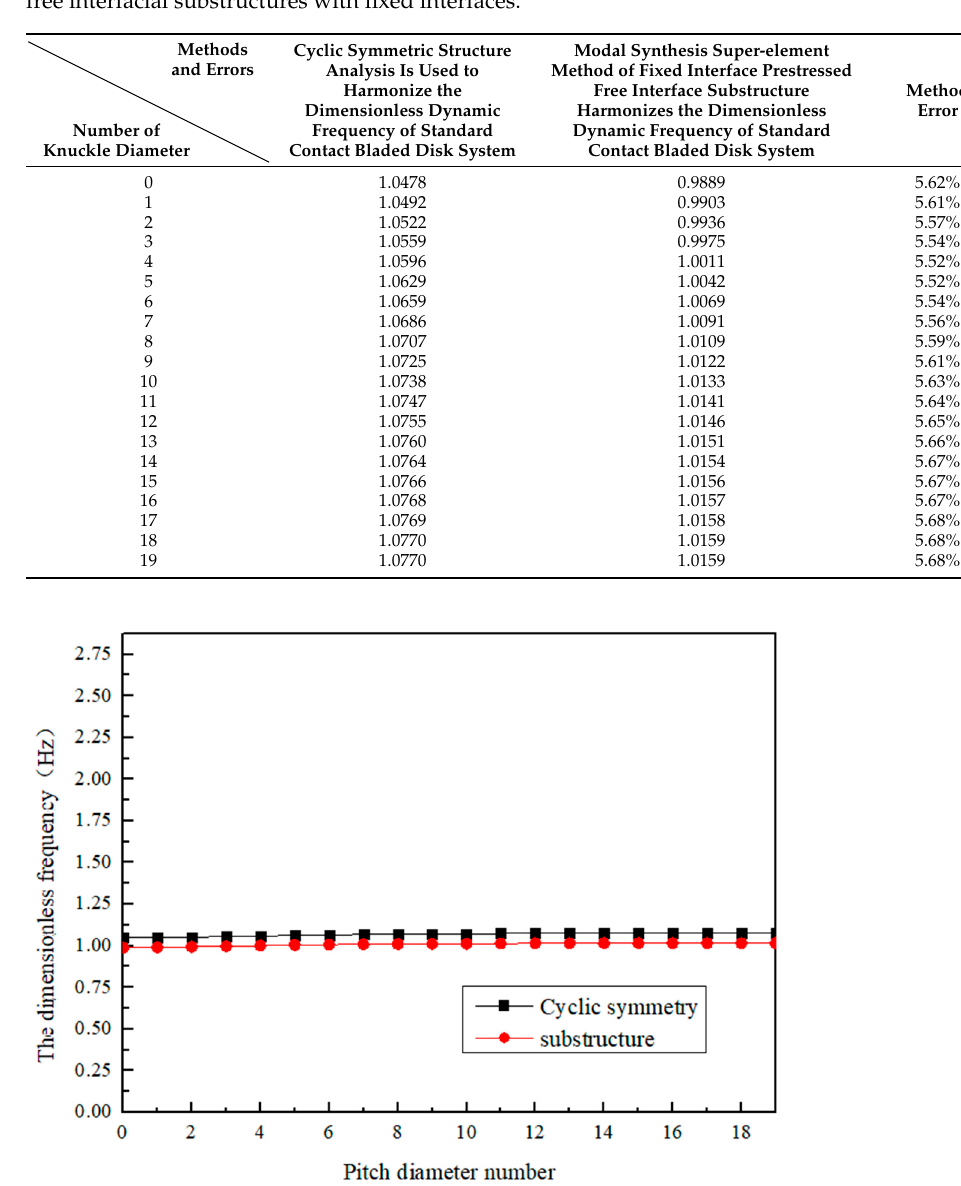
Figure 3. First-order dynamic frequency of the substructure method and cyclic commutation method.